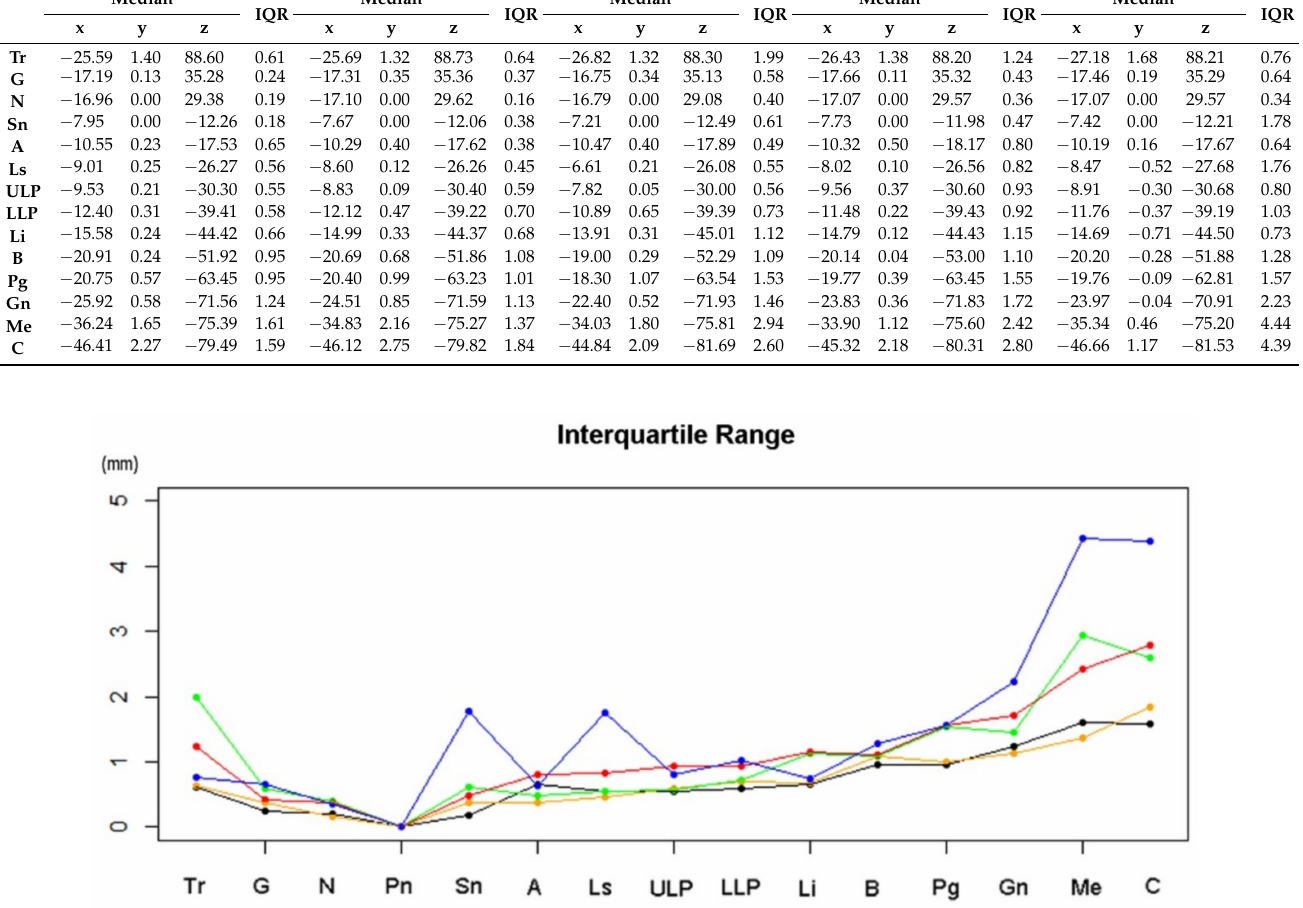
Figure 3. Interquartile Range (IQR) distribution: D+10 ◦ ( red ), D+5 ◦ ( orange ), D − 0 ◦ ( black ), D − 5 ◦ ( green ), and D − 10 ◦ ( blue